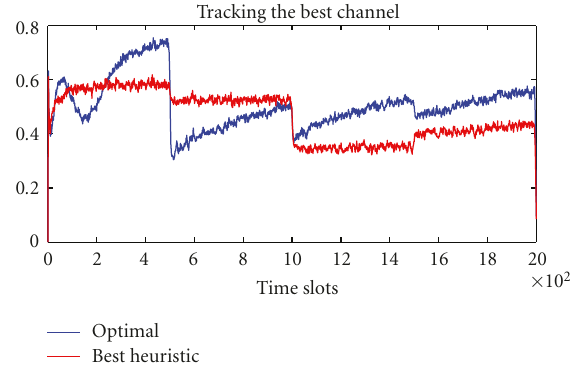
Figure 10: The optimal channel selection tracks the best channel even if the tra ffi c parameters change during the simulation